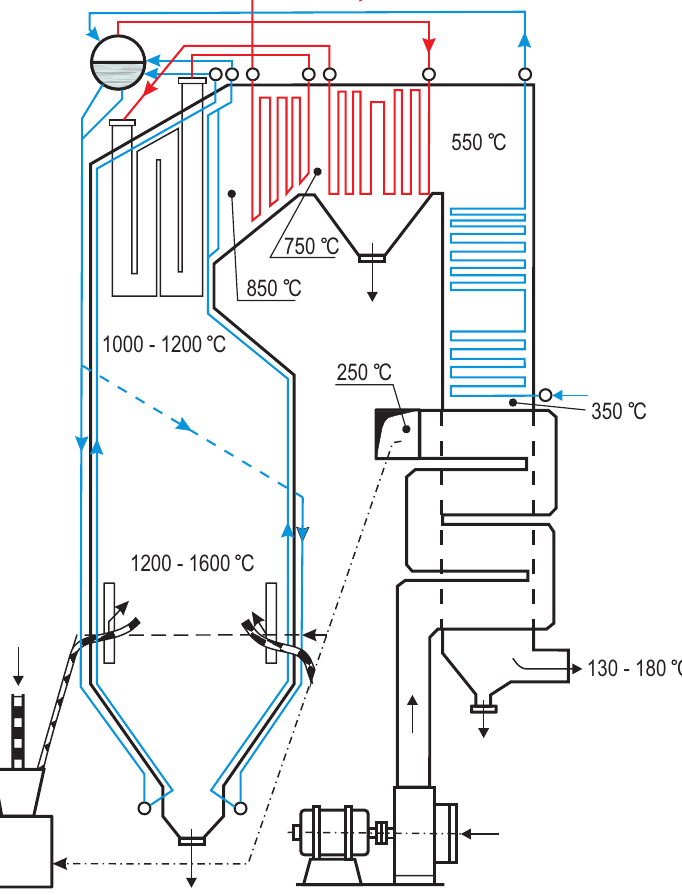
Figure 2. The schematic view of the OP-230 boiler